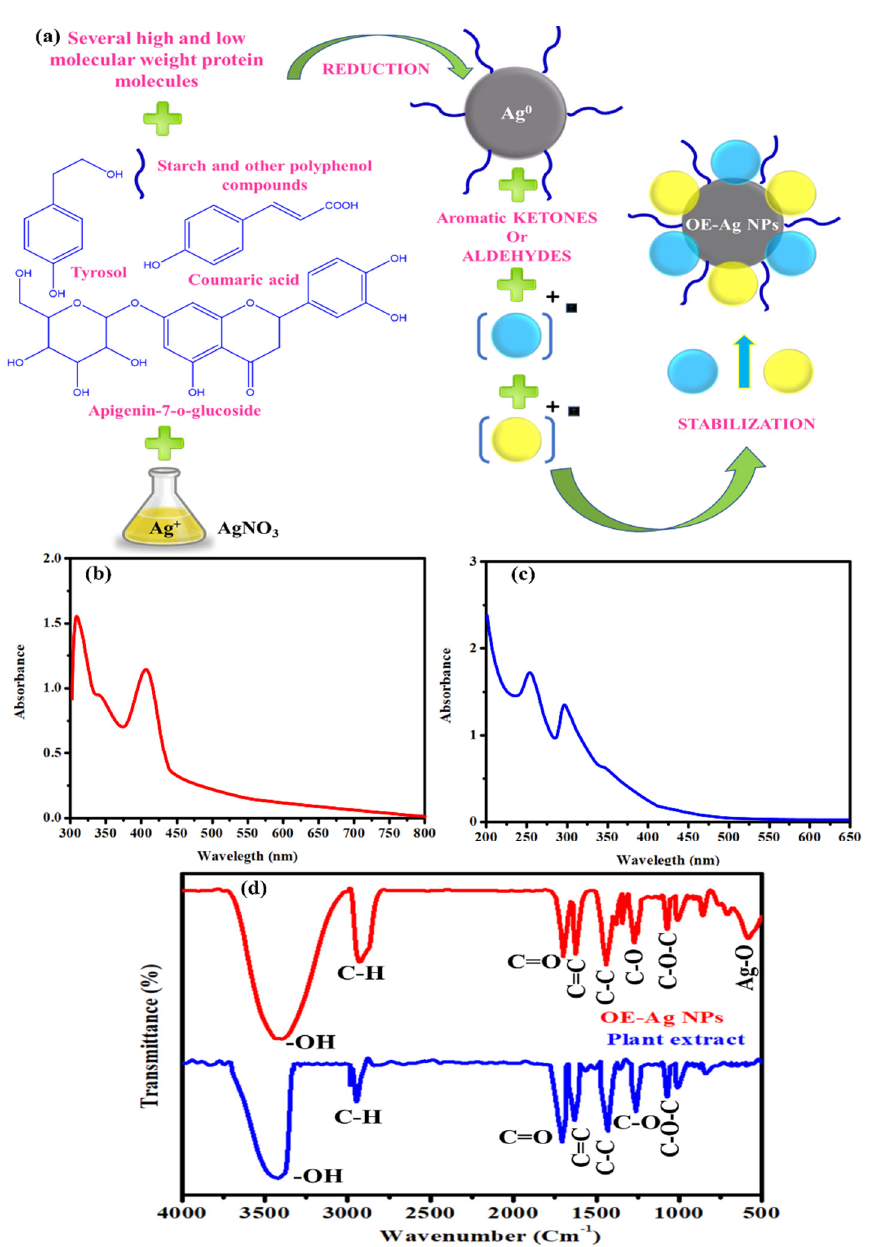
Figure 1. ( a ) Probable mechanism for the synthesis of OE-Ag NPs. ( b , c ) UV-Visible spectra of OE-Ag NPs and plant extract respectively. ( d ) FTIR analysis of plant extract and OE-Ag NPs. The chemical reaction between the dissolved silver ions and plant leaf extract was examined with a UV-Visible spectrophotometer. UV-Visible analysis revealed that upon reaction completion and formation of OE-Ag NPs, an absorption peak at 410 nm was observed due to the surface plasmon resonance phenomenon (Figure 1b) [26]. An addi- tional absorption peak at 310 nm was also observed, which might be due to the adsorbed polyphenols. Literature shows that polyphenols usually produce UV-Visible absorption peaks in the ultra-violet region due to the presence of hydroxyl moieties [27–30]. On